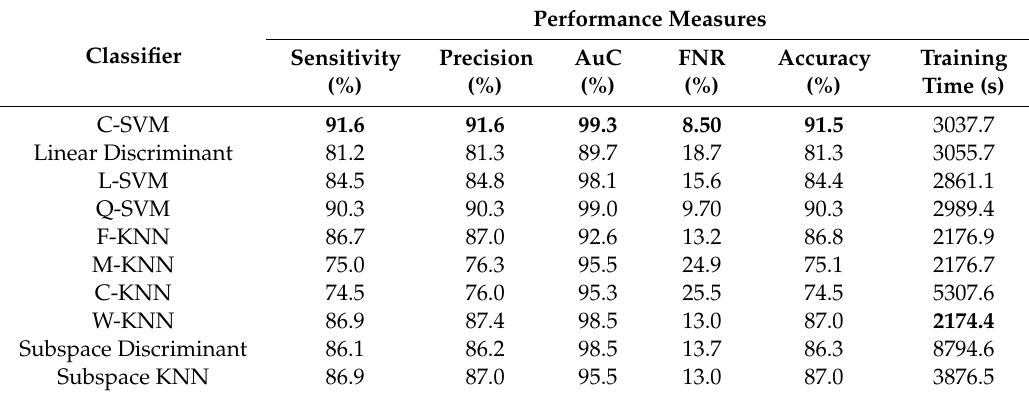
Table 4. Classification results after feature fusion. Best values are shown in